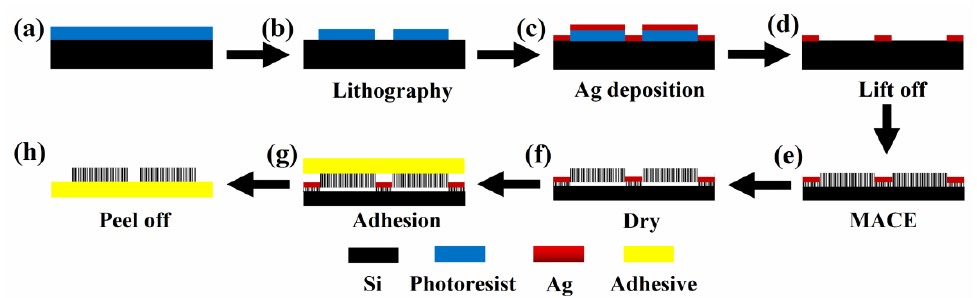
Figure 1. Schematic of the transfer process of vertical PSi film. ( a ) Spin coating of photoresist, ( b ) lithography, ( c ) Ag deposition, ( d ) lift off, ( e ) MACE, ( f ) drying, ( g ) adhesion, ( h ) peel off. PSi is formed on Si wafer surface without metal coverage as observed in previous work [20,21]. During the etching process, Ag can be oxidized to Ag + by H 2 O 2 . Alternatively, these Ag + can be quickly reduced back to Ag at the interface of Ag and Si. Pores